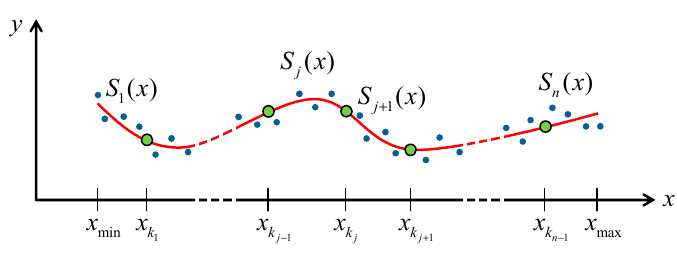
Figure 2. Spline approximation after Ezhov et al. [2].